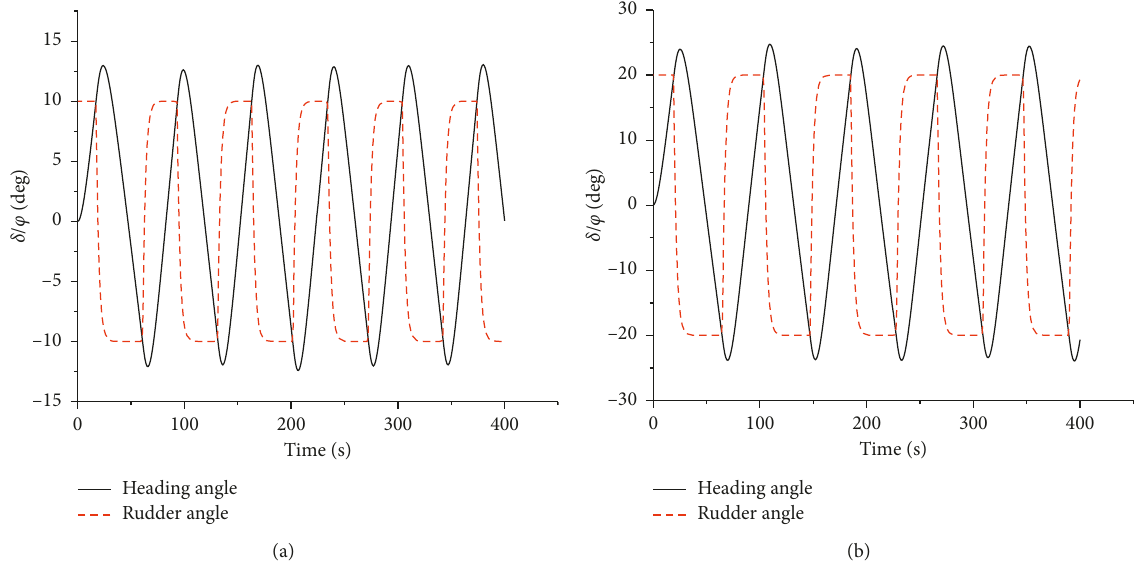
Figure 10: Results of zig-zag test. (a) Time history curve of heading angle 10. (b) Time history curve of heading angle 20.